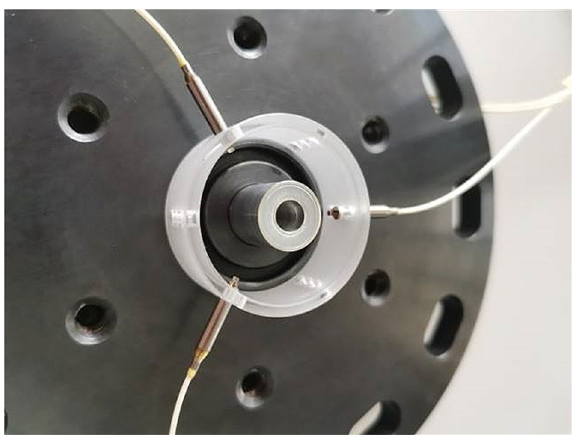
Figure 4. Assembled liners and external photonic Doppler velocimetry probes.